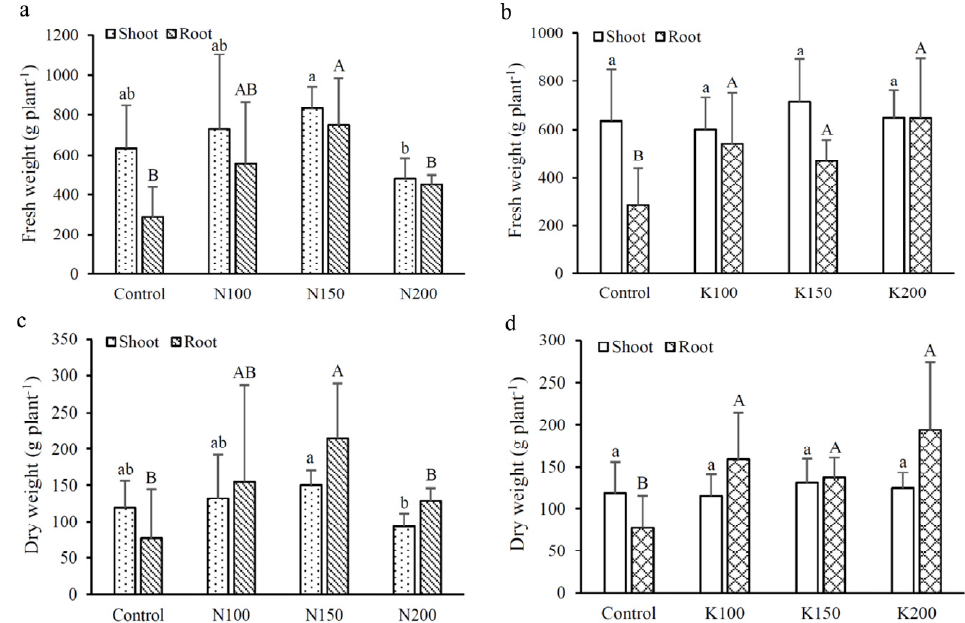
Figure 2. Effects of different fertilizer treatments on the shoot and root biomass of C. taiwanianum : ( a , b ) fresh weight; ( c , d ) dry weight. Values are mean ± standard deviation ( n = 4). The bars with different letters within the same fertilizer treatment (N treatments: Control, N100, N150 and N200; K treatments: Control, K100, K150 and K200) of shoots (lowercase letters) and roots (uppercase letters) are significantly different ( p < 0.05, LSD tests).